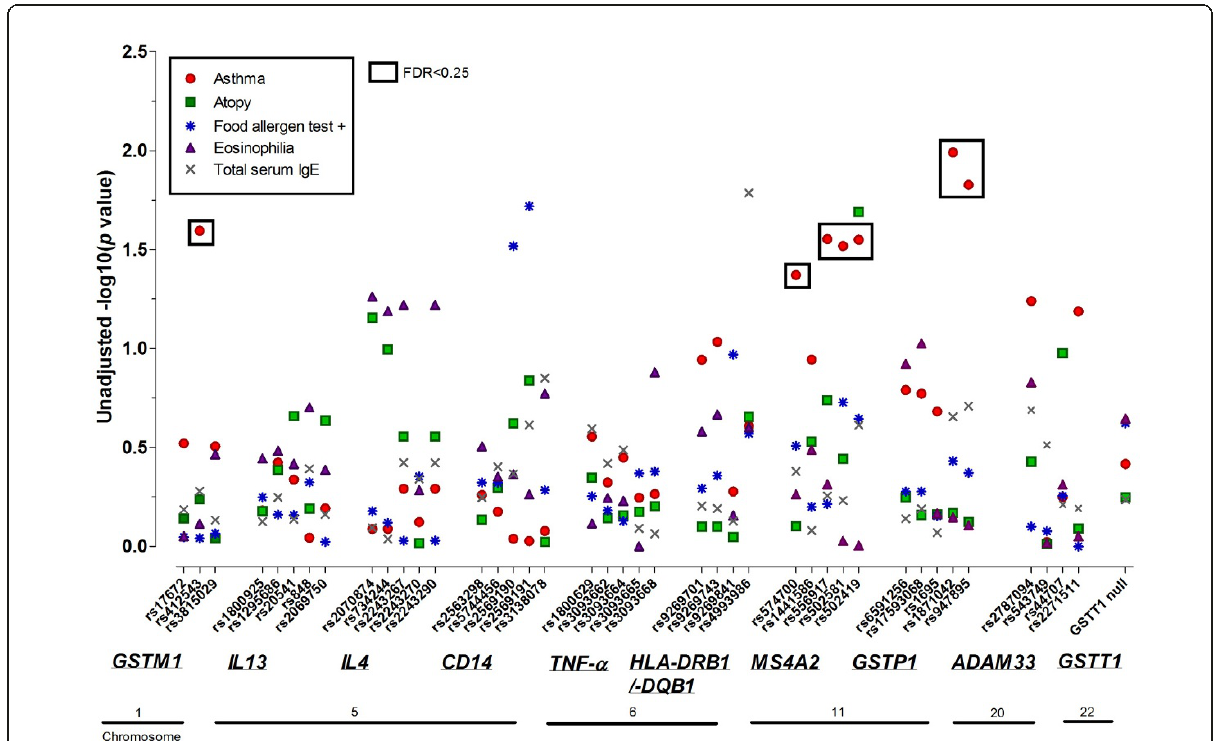
Figure 1 Segmented Manhattan plot displaying SNP associations with asthma/allergy traits . Negative log-transformed p -value (-log( p )) indicative of statistical significance for the association between each SNP and trait, where higher -log( p ) values correspond to greater statistical significance. SNPs significant based on FDR < 0.25 indicated with a black